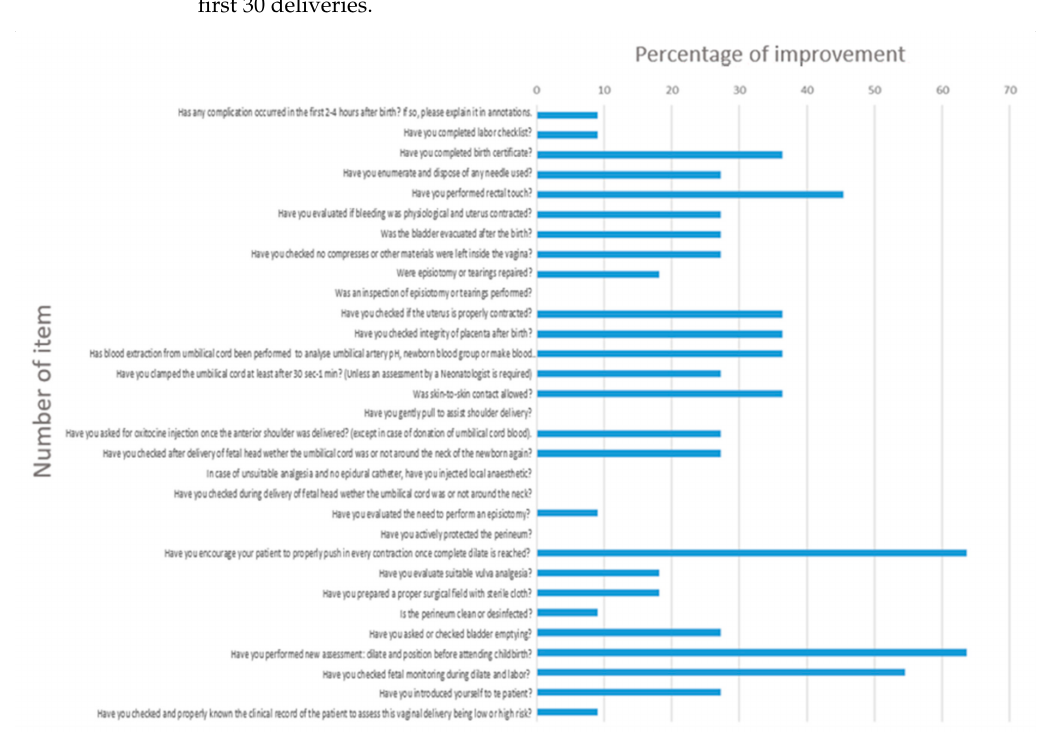
Figure 4. Percentage of students showing improvement and analysis of each item, after comparing the mean of “Yes” responses between the first five and last five CLs